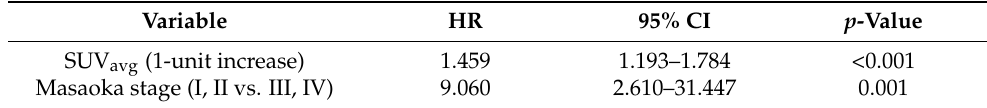
Table 4. Multivariate analysis for time-to-progression using a Cox proportional hazard model.